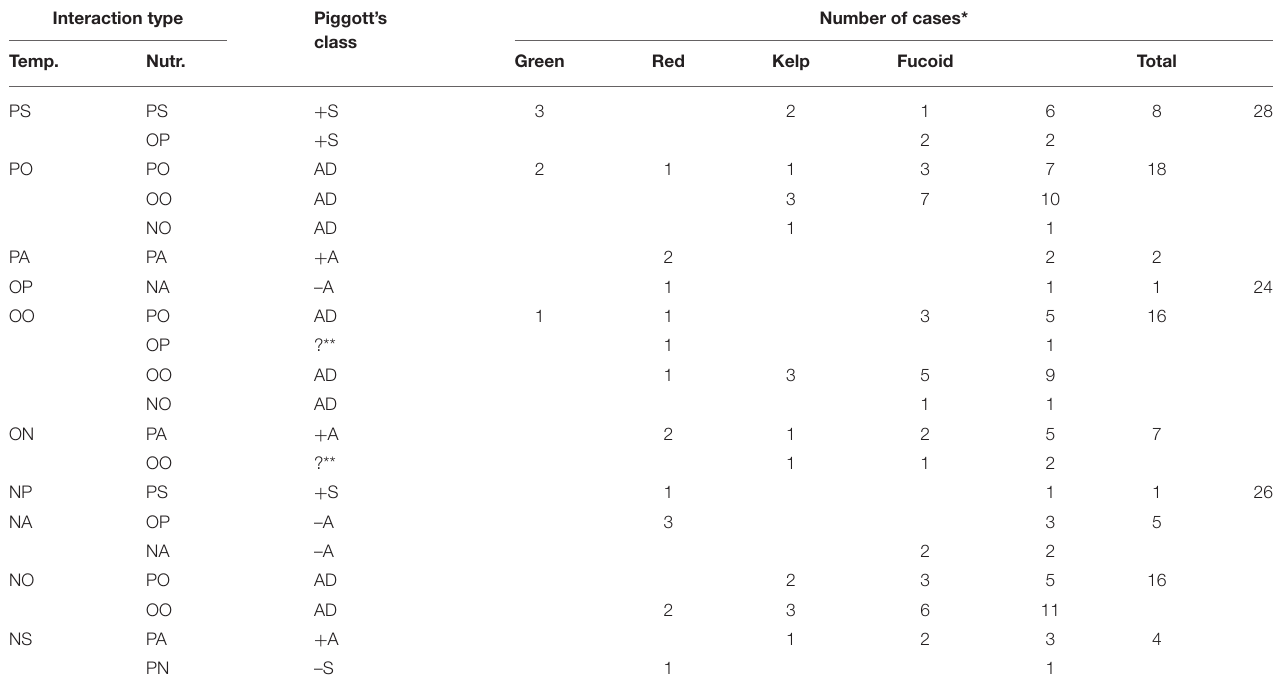
Abbreviations as in Table 1 . ** This type of interaction is not recognized by the scheme of Piggott et al. (2015).